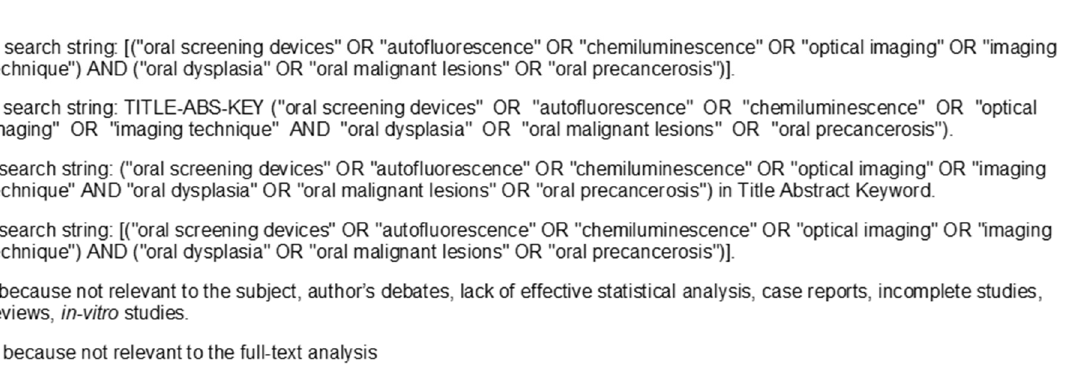
Figure 1. The flowchart of the search.